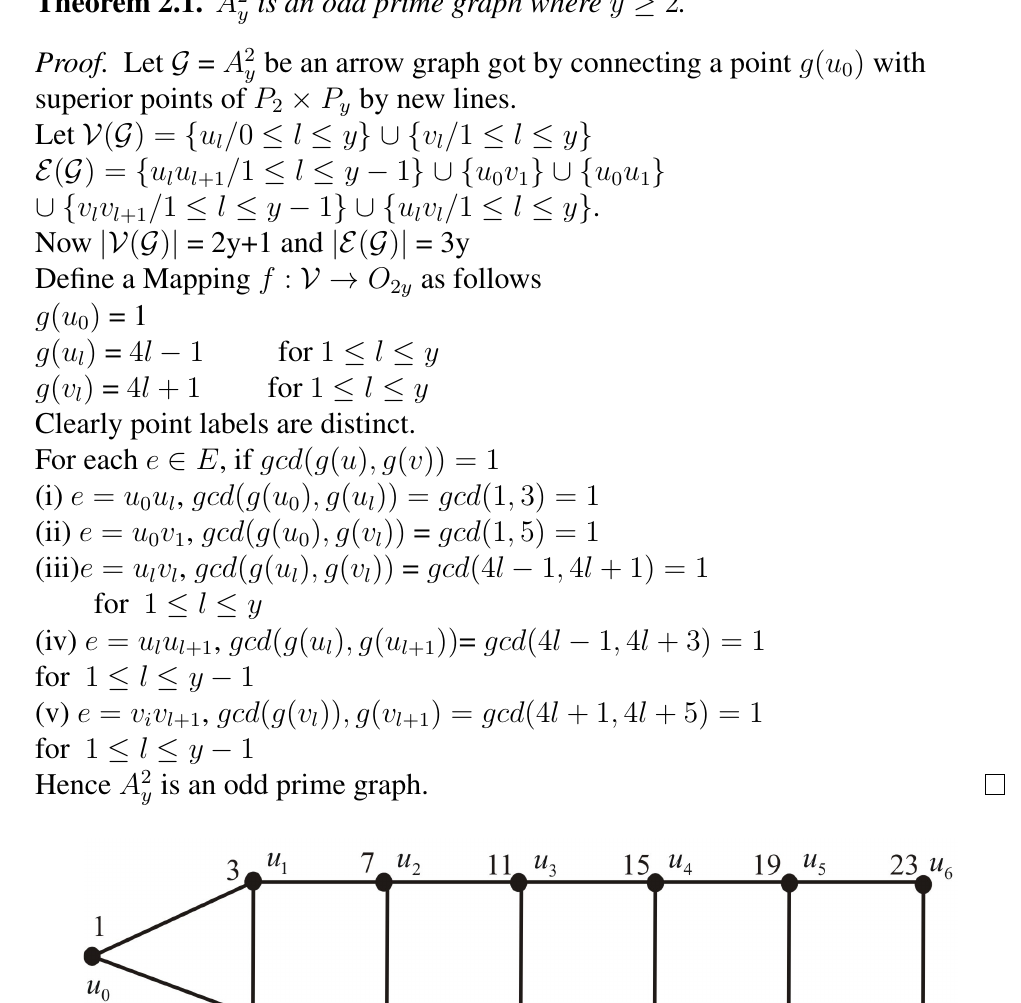
Figure 1: Arrow graph A 2